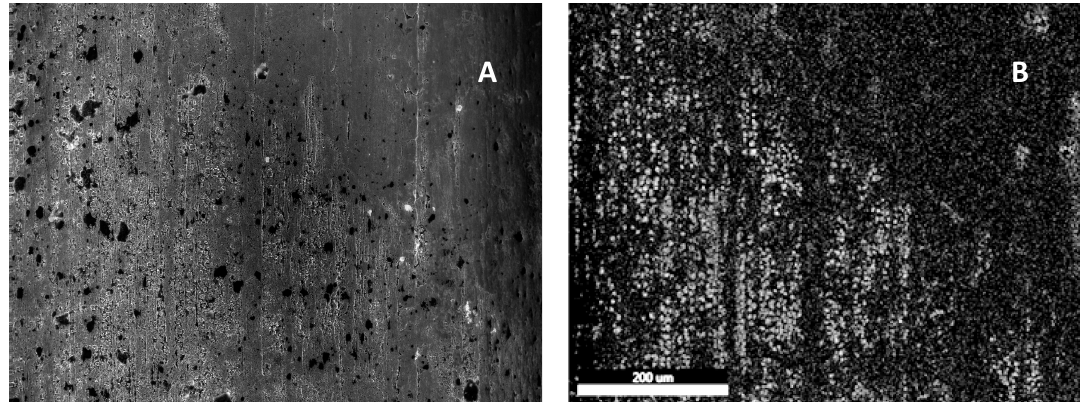
Figure 3. Scanning electron microscope (SEM) and Energy Dispersive X-ray Analysis (EDXA) Map of Interface—( A ) The SEM image of the interface shows chrome is present in unconnected spots (particles). ( B ) An EDXA map of the chrome signal verifies that the light colored areas in the image are metallic chrome.